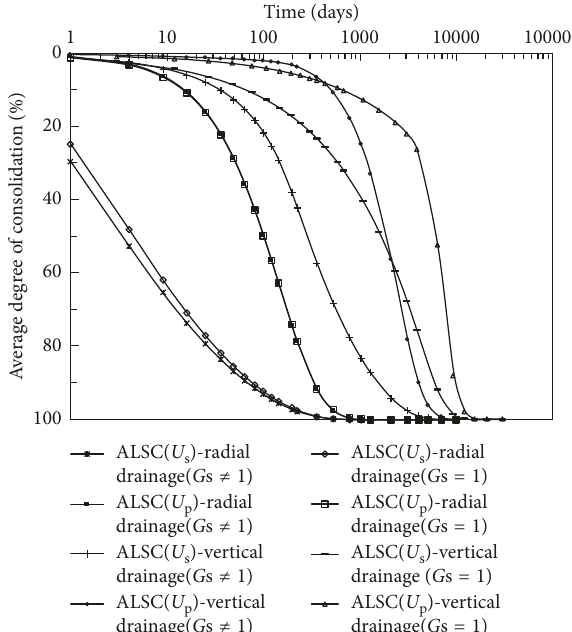
Figure 7: Effect of self-weight on the average degree of consoli- dation of radial flows only and vertical flows only.